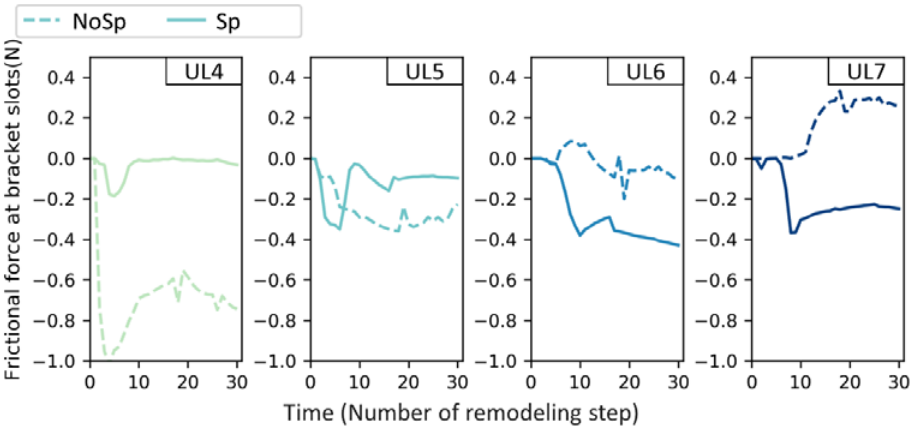
Figure 7. Changes in the frictional force at the bracket slots on each tooth over time.